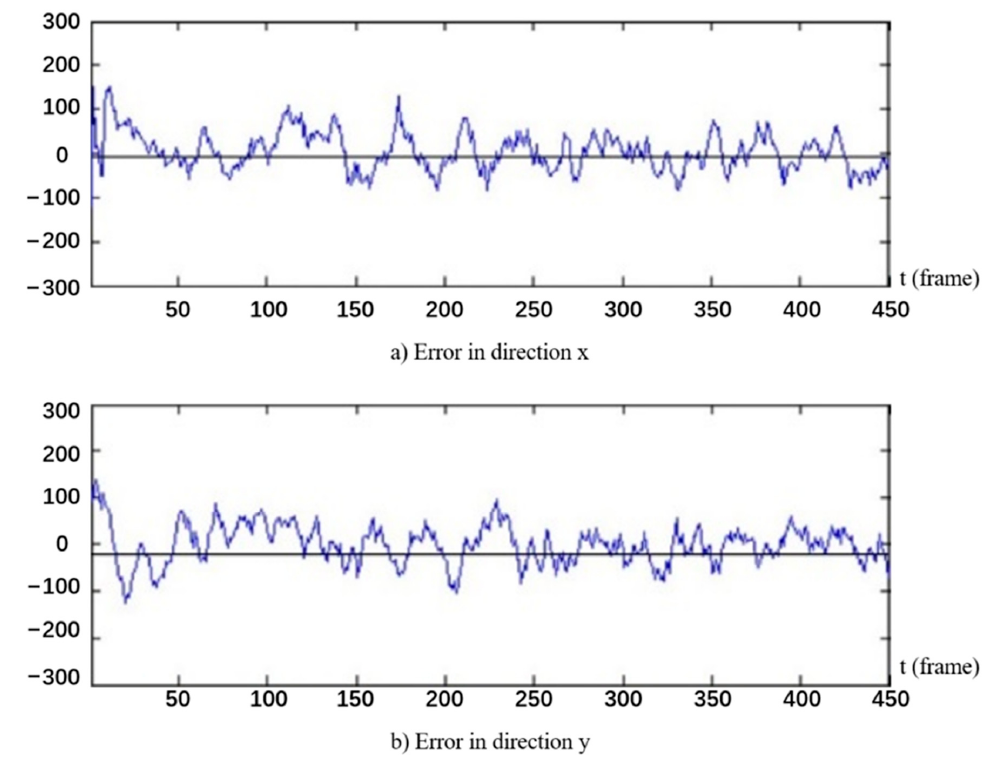
Figure 15. Positioning